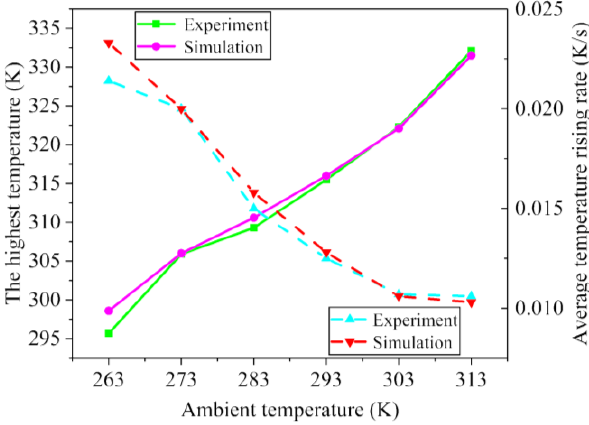
Figure 14. Comparison of the highest temperature and average temperature rise rate of battery pack.